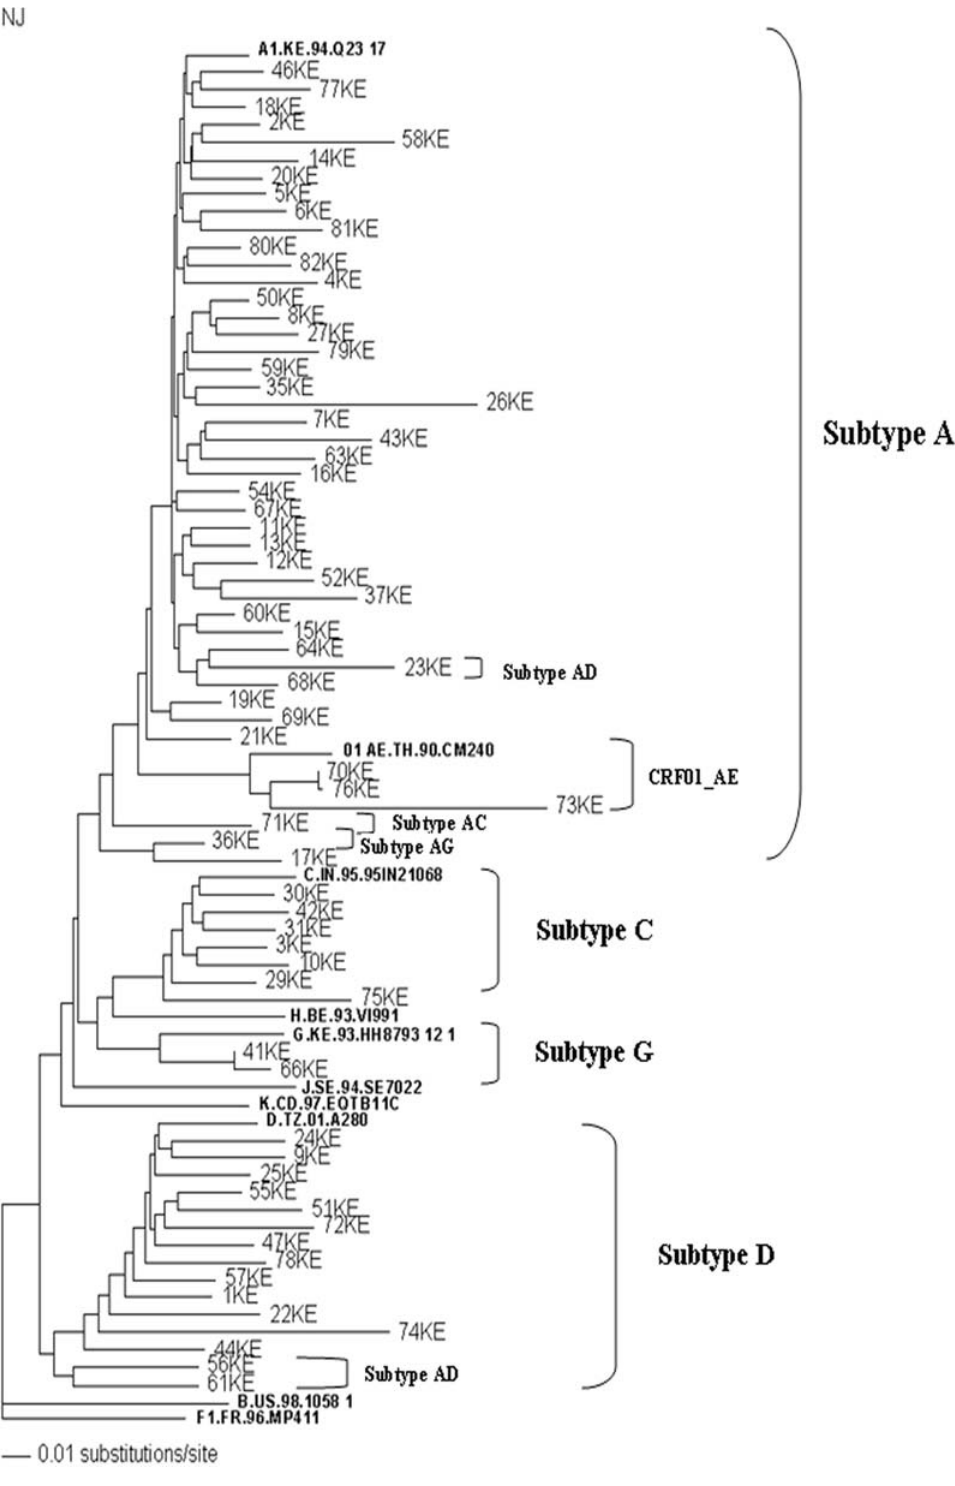
Figure 1. Phylogenetic analysis of HIV gag gene (p24-p7) sequences (nt 1577–2040, HXB2) from HIV infected Nairobi residents. This tree (neighbor-joining) was created by aligning the selected sequences with reference sequences from Los Alamos database shown in bold). The sequence F1.FR.96.MP411 was selected as the out group.